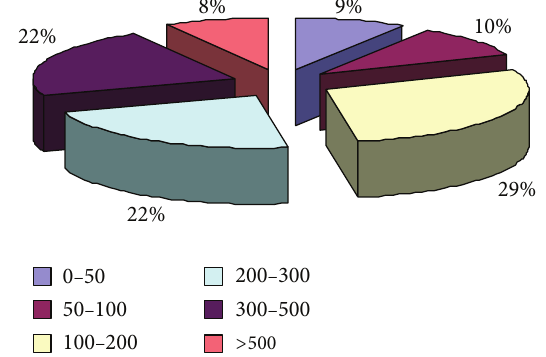
Table 4: Species distribution of different fungal